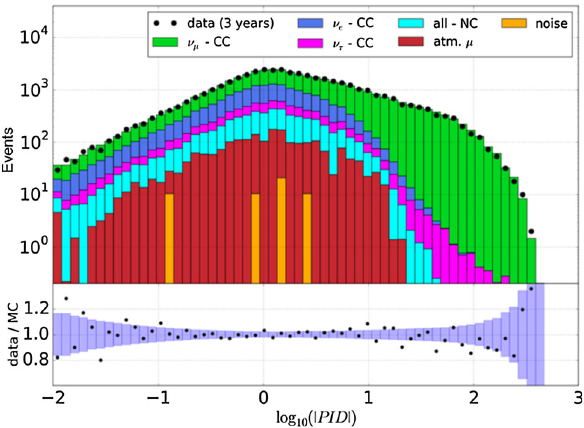
Fig. 3 The distribution of the particle identification variable for Anal- ysis A . The blue band on the data/MC ratio is the statistical